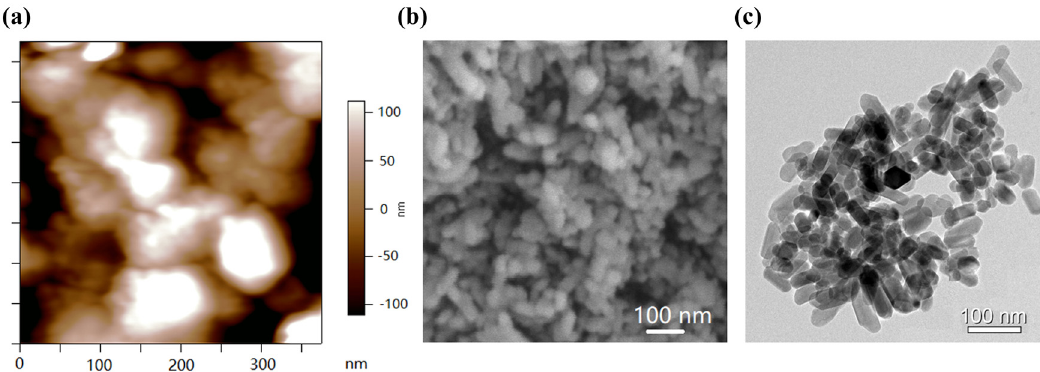
Figure 1: The morphology of the n - HA powders, based on the calculation of image J processing software, the average diameter of the HA powders was 75 ± 20 nm. ( a ) AFM image of the n - HA powders; ( b ) SEM image of the n - HA powders; and ( c ) TEM image of n - HA